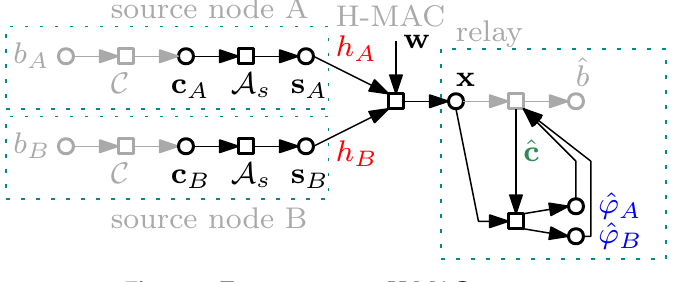
Figure 1. Two-component H-MAC